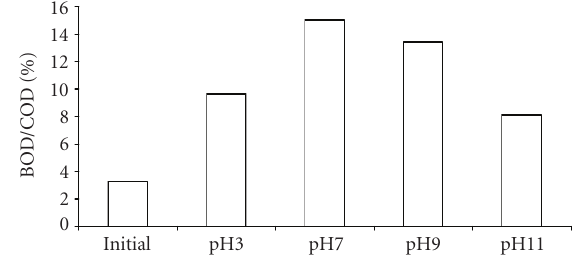
Figure 3: The increase of BOD/COD ratio in PCO treatment time at di ff erent pH: initial concentration of lignin 100 mg L − 1 ; plate 0.75 mg cm − 2 (spraying), treatment time 24hours.